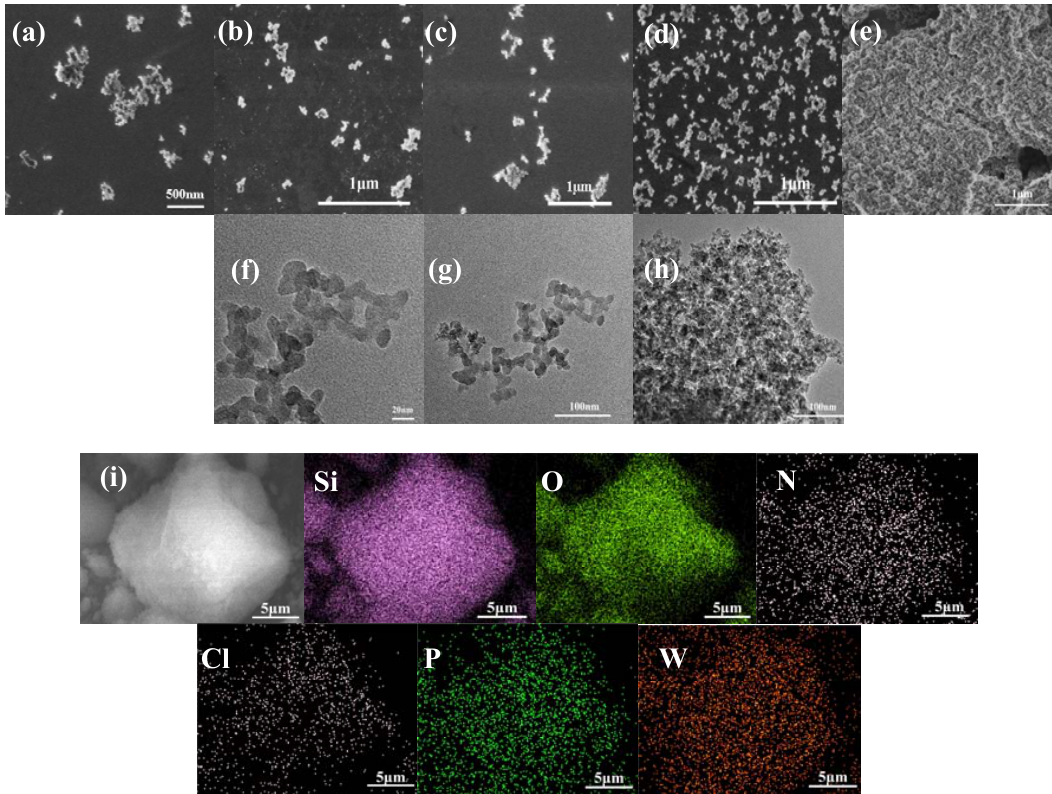
Figure 2. Thermogravimetric curves of ( a ) SiO 2 ; ( b ) SiO 2 -Cl; ( c ) SiO 2 -Im; ( d ) SiO 2 Im + Cl − SiO 2 ; and ( e ) PW(0.058)/SiO 2 Im + Cl − SiO 2 .